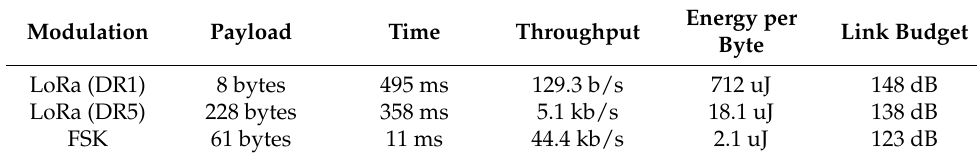
Figure 8. Current consumption while streaming IMU data sampled at 100 Hz. Table 1. Communication modes performance analysis.